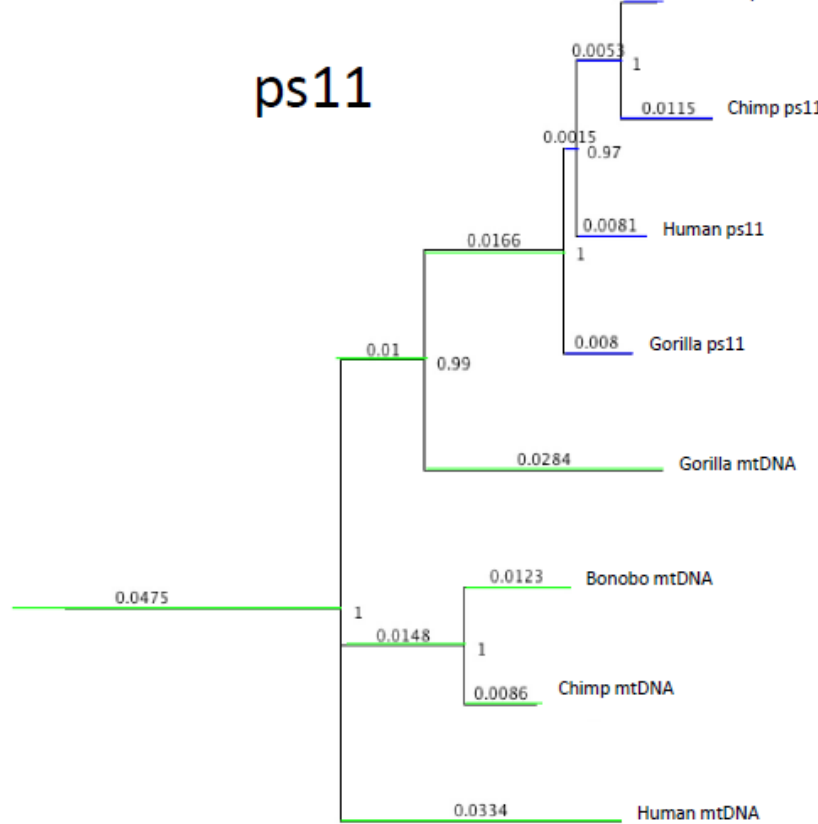
Figure 3. Phylogenetics of the pseudogene Ps11 and Hominine mtDNA. PhyML GTR. Note that this tree is still under construction; there are some unresolved problems in topology. In fact, this particular region of mtDNA is generally not apt for genealogical analysis because of high conservation and high selective pressures (as it is an rRNA coding region).